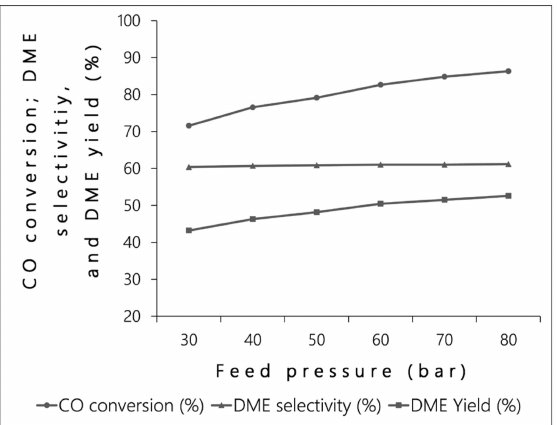
Figure 7. Influence of the feed pressure on CO conversion, DME selectivity, and DME yield.